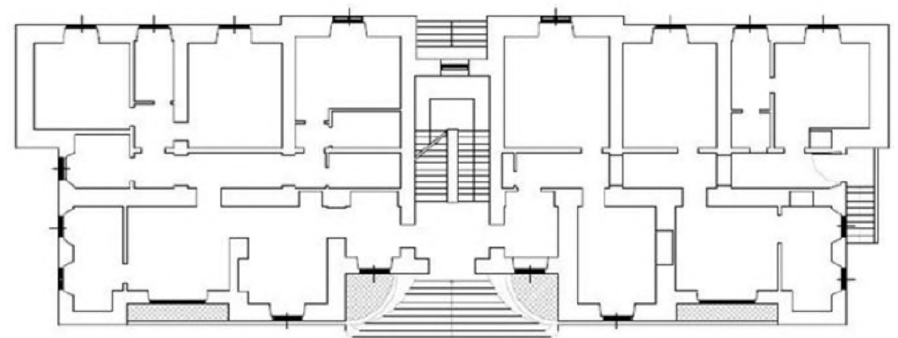
Figure 7. Plan of the masonry palace.